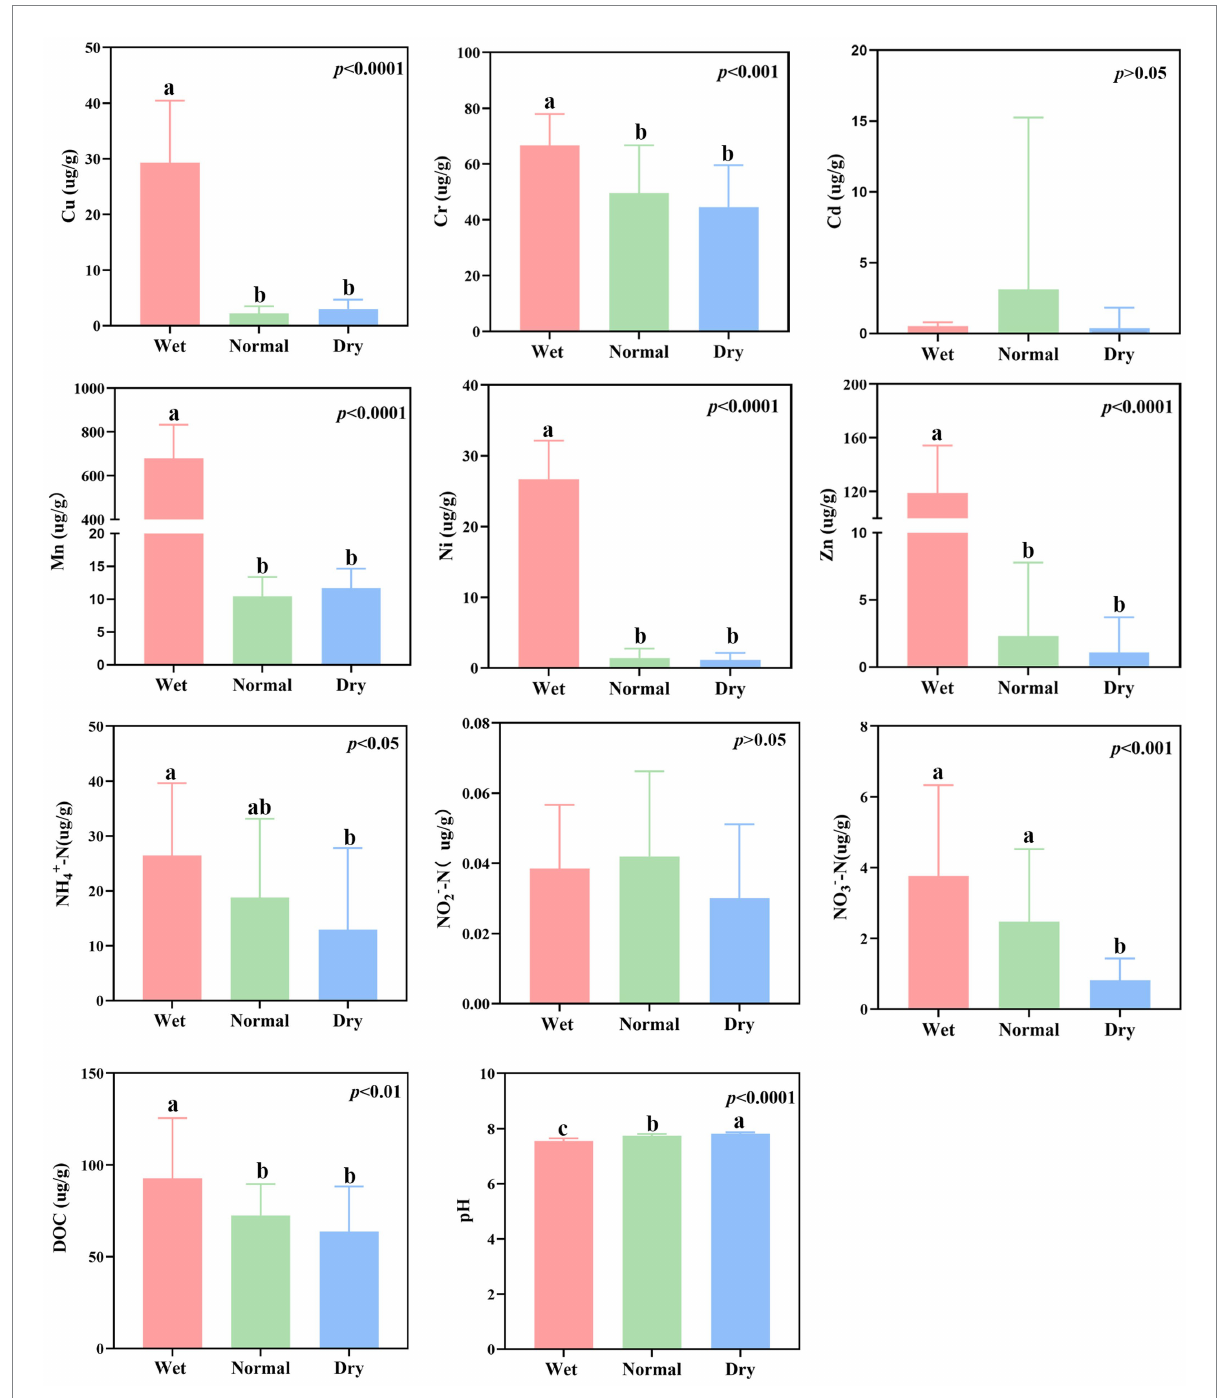
FIGURE 4 One-way ANOVA showing the dynamics of environmental factors during wet, normal, and dry seasons. Different letters indicated significant difference by Duncan test ( p <